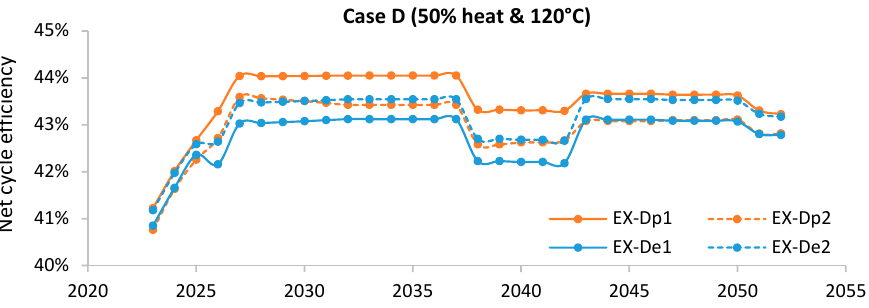
Figure 10. Performances of extraction steam turbine cycles defined for case D.